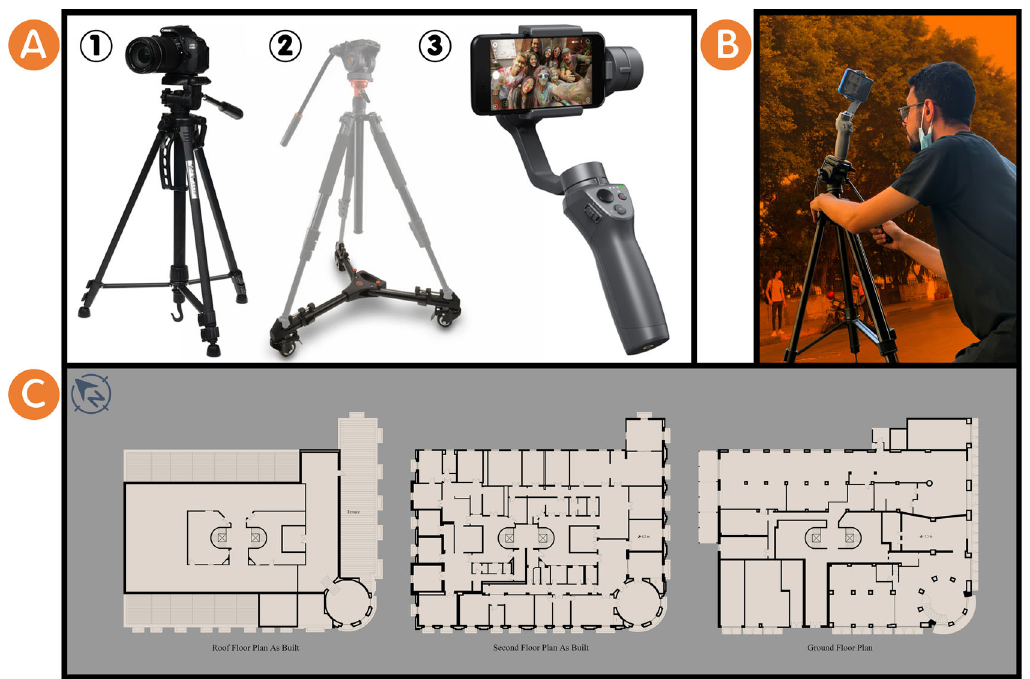
Figure 2. (A) The tools used in surveying the Société Immobilière building are (1) DSLR camera with a professional camera tripod, (2) Padcaster tripod dolly wheel, and (3) Smartphone with DJI Osmo